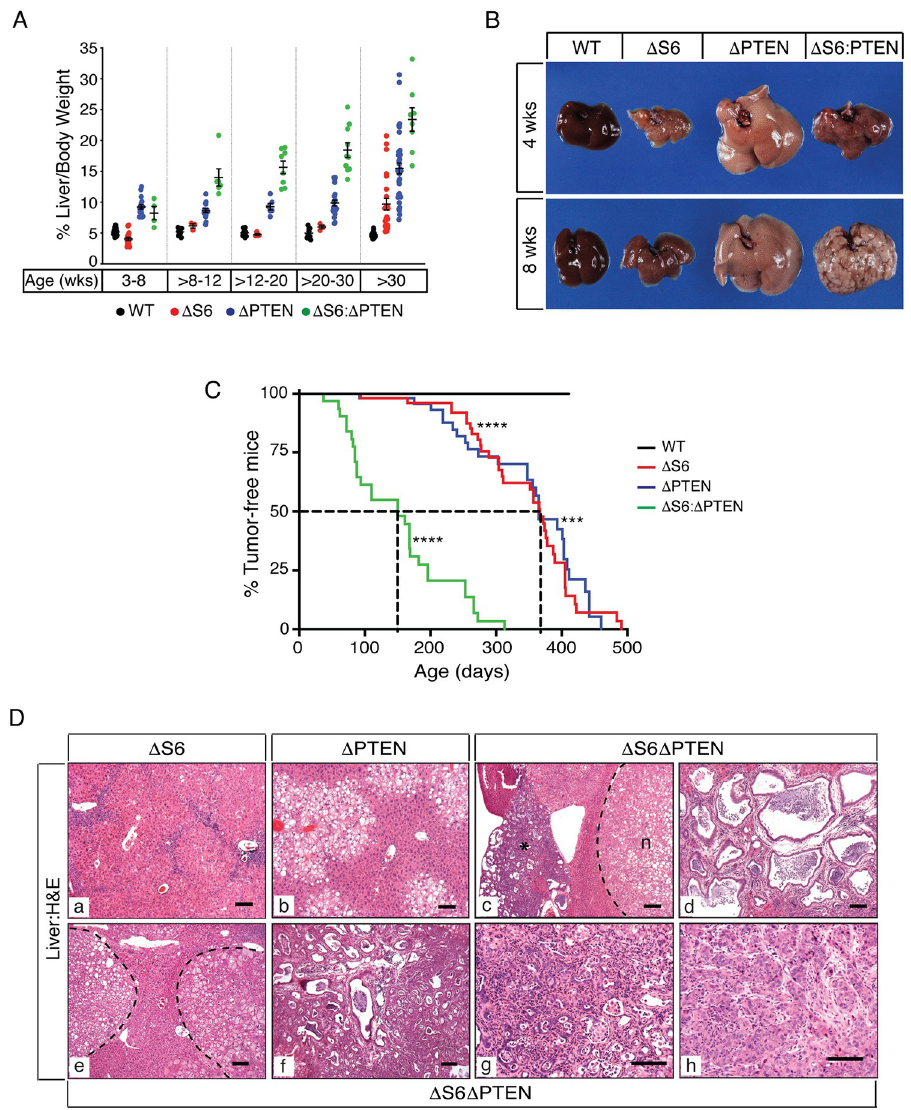
Fig 6. Rps6-deficiency lowers the threshold for tumor development in PTEN-deficient livers. (A) Graph of %L/ BWs in WT, Δ S6, Δ PTEN and Δ S6 Δ PTEN mice at different ages showing accelerated growth of Δ S6 Δ PTEN livers from ~12 weeks of age. For mean %L/BWs and P values, please see S2 Table. (B) Gross appearance of WT, Δ S6, Δ PTEN and Δ S6 Δ PTEN livers at 4 and 8 weeks of age. Note the dramatic change in appearance of the Δ S6 Δ PTEN liver between 4–8 weeks age as fatty nodules develop. (C) Kaplan-Meier curve showing % of liver tumor-free WT, Δ S6, Δ PTEN and Δ S6 Δ PTEN mice. Age at which 50% of Δ S6, Δ PTEN and Δ S6 Δ PTEN mice develop at least 1 liver tumor is 367, 365 and 150 days respectively. ��� , P = .0001; ���� , P < .0001. (Log-rank (Mantel-Cox) test). (D) Photomicrographs of H&E stained liver sections from a) a 3 month old Δ S6 mouse showing regenerative nodules and remnants of the dr, b) a 5.5 month old Δ PTEN mouse showing typical pericentral steatosis, c) a 5.5 month old Δ S6 Δ PTEN mouse showing a nodule (n) compressing the parenchyma adjacent to an area displaying bile duct hamartomas ( � ), d) a 5.5 month old Δ S6 Δ PTEN mouse with a bile duct hamartoma, e) a 10 week old Δ S6 Δ PTEN mouse with fatty adenomas, f) an 8 week old and g) a 3 month old Δ S6 Δ PTEN mouse with cholangiocarcinomas, and h) an 11 month old Δ S6 Δ PTEN mouse with a trabecular HCC (f). Dashed lines denote nodule boundaries. Original magnifications; a, b, c, d (x 62.5); e, f (x 56.25); g, h (x 125); Scale bars, all 50 μ .